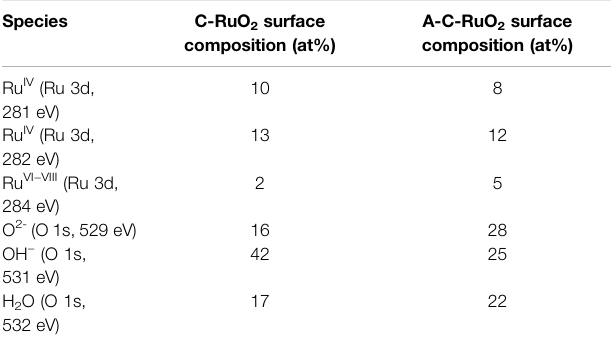
TABLE 1 | Atomic percentages of ruthenium and oxygen surface species determined from XPS core level spectra. Species C-RuO 2 surface A-C-RuO 2 surface composition (at%) composition (at%)